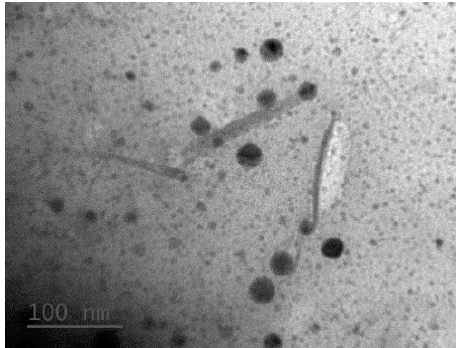
Figure 8. TEM observation of sample “200P”.